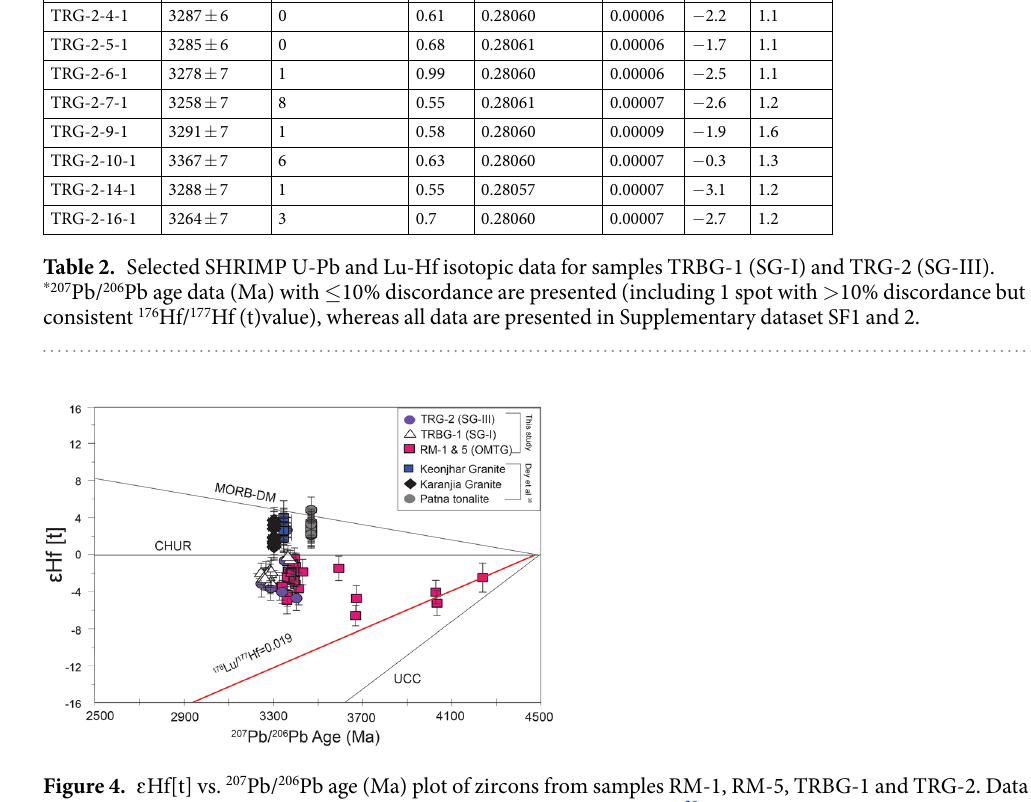
(0.28041 ± 0.00007) that is higher than those of the older Hadean and Eoarchean age spots. The ~3.3-3.4 Ga age group of zircons from samples RM-1 and RM-5 yields more radiogenic ε Hf[t] values than Hadean and Eoarchean age spots, ranging from − 0.4 ± 1.2 to − 3.7 ± 1.8, except for two data points that fall below − 4 epsilon units ( − 4.9 ± 1.5 and − 4.3 ± 1.3). Initial Hf ratios of these spots are identical to those of other age spots with lower ε Hf[t] values, implying that they were derived from the same source. Initial 176 Hf/ 177 Hf values of the ∼ 3.3-3.4 Ga zircons display a relatively small range of values, varying between 0.28047–0.28057, identical with the aver- age of 0.28053 ± 0.00003. This range also includes 176 Hf/ 177 Hf initial values of four discordant age spots (10–15% discordance; Table 1), indicating that despite having undergone U-Pb resetting, their Hf isotopic ratios remain unchanged. The ~3.3-3.4 Ga zircons do not exhibit any particular trend in ε Hf[t]-time space, but they cluster within the field delimited by the 176 Lu/ 177 Hf = 0.019 array defined by the Hadean zircon data and the CHUR refer- ence line ( ε Hf = 0; Fig. 4). This indicates, unlike Zack Hill zircons, the younger zircons of OMTG are not derived from the same source as the oldest crust. The ɛ Hf[t] values of the 3397 ± 9 Ma zircons from sample TRBG-I (SG-I) and 3286 ± 6 Ma zircons from sample TRG-2 (SG-III) are all subchondritic, yielding ɛ Hf[t] values ranging from − 0.7 ± 1.3 to − 4.7 ± 1.3 and from − 0.3 ± 1.1 to − 3.1 ± 1.2, respectively (Table 2), similar to the 3.3-3.4 Ga age group of the OMTG zircons. However, a TRBG-1 analytical site with an age of 3361 ± 7 Ga yields an ɛ Hf[t] value of + 2.6 ± 1.4 (spot 3.1), which is the only superchondritic value among our entire dataset. The oldest age spot (3404 ± 7 Ma) of the TRBG-1 zircons yields an initial Hf ratio of 0.28045 ± 0.00007 and an ɛ Hf[t] value of − 4.7 ± 1.3. Likewise, the site with an age of 3361 ± 7 Ma yields the highest radiogenic initial Hf composition of 0.28068 ± 0.00008 among